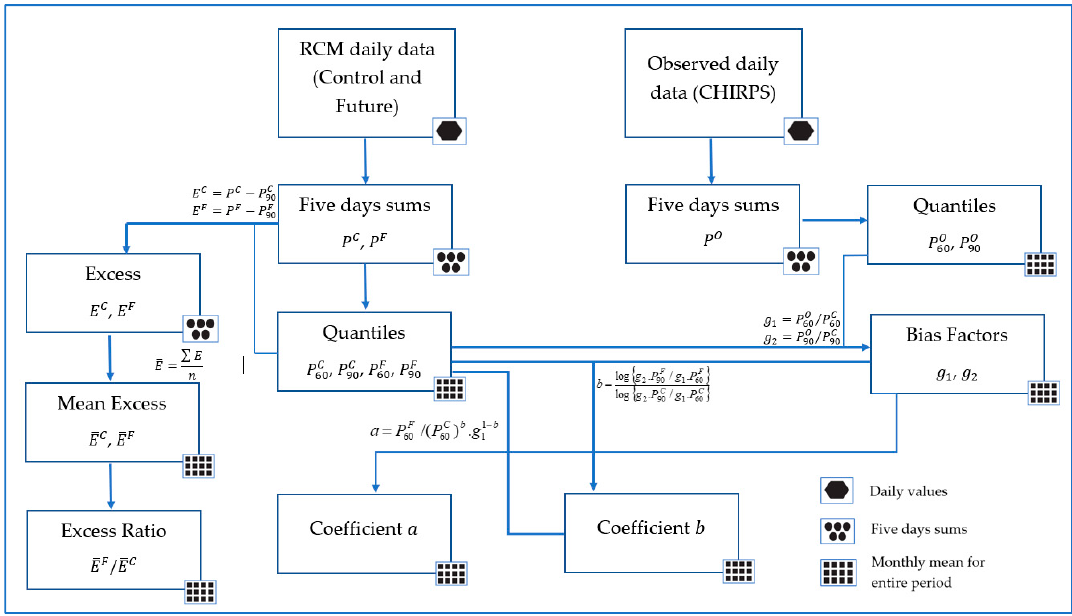
Figure 5. Flowchart of the parameter calculation steps of the advanced delta change method (adapted from [42]) .